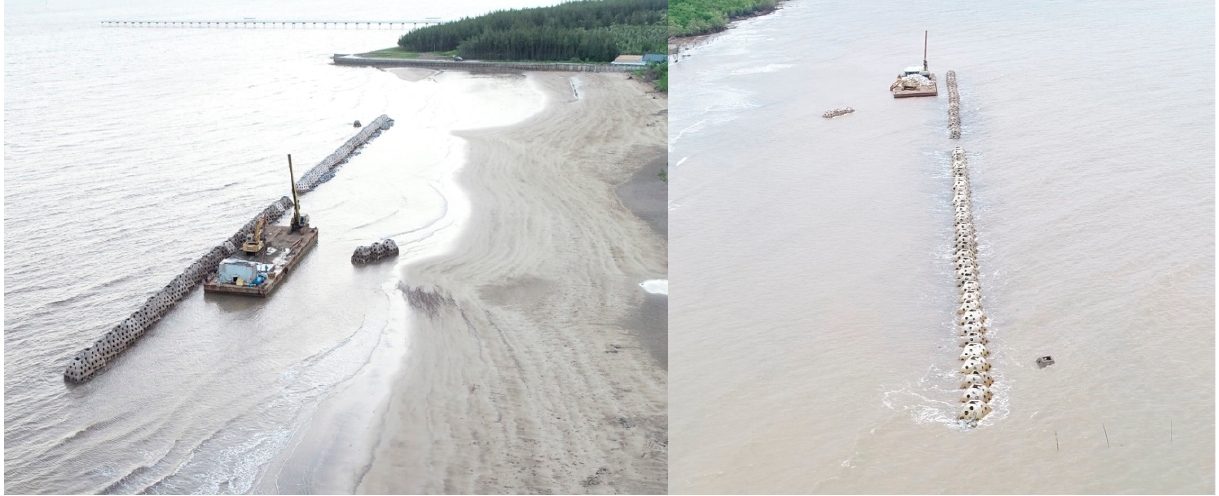
Figure 17. Wave breakwaters with PTPBW structure, which was designed on the basis of the present research results.